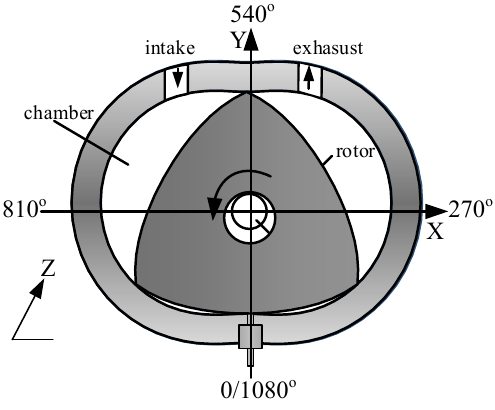
Figure 1. Schematic of small rotary engine. Table 1. Small rotary engine specifications.